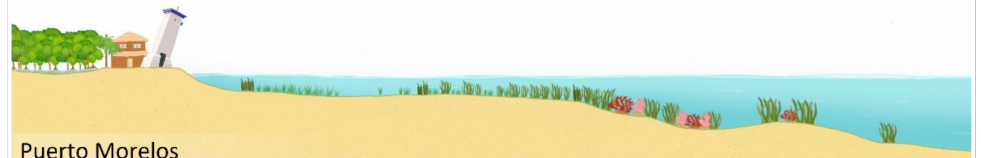
Figure 11. Schematisation of the distribution of coastal environments and characteristic coastal infrastructure at Puerto